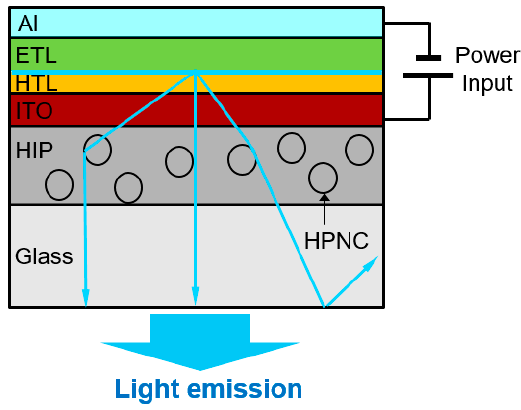
Figure 1. Cross-sectional view of organic light emitting diodes (OLED) incorporated with hollow polymeric nanocapsules (HPNCs).